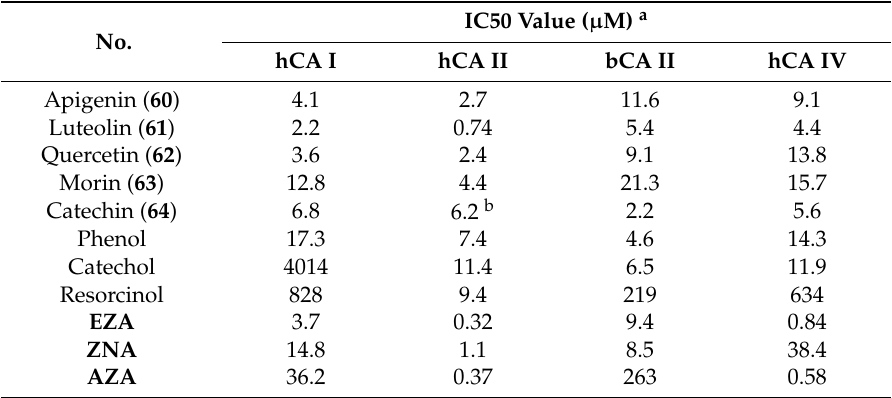
Table 6. Inhibition of hCA isozymes I, II and IV and bCA III with compounds 60 – 64 , EZA , ZNA and AZA by the esterase activity.